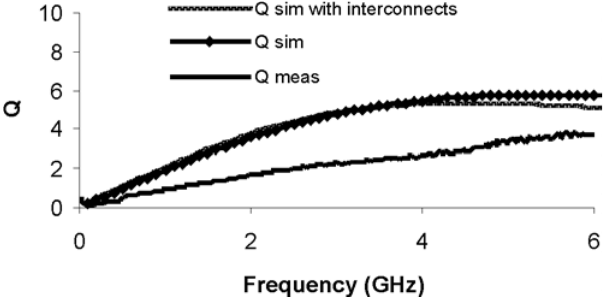
FIGURE 7 Small inductance quality